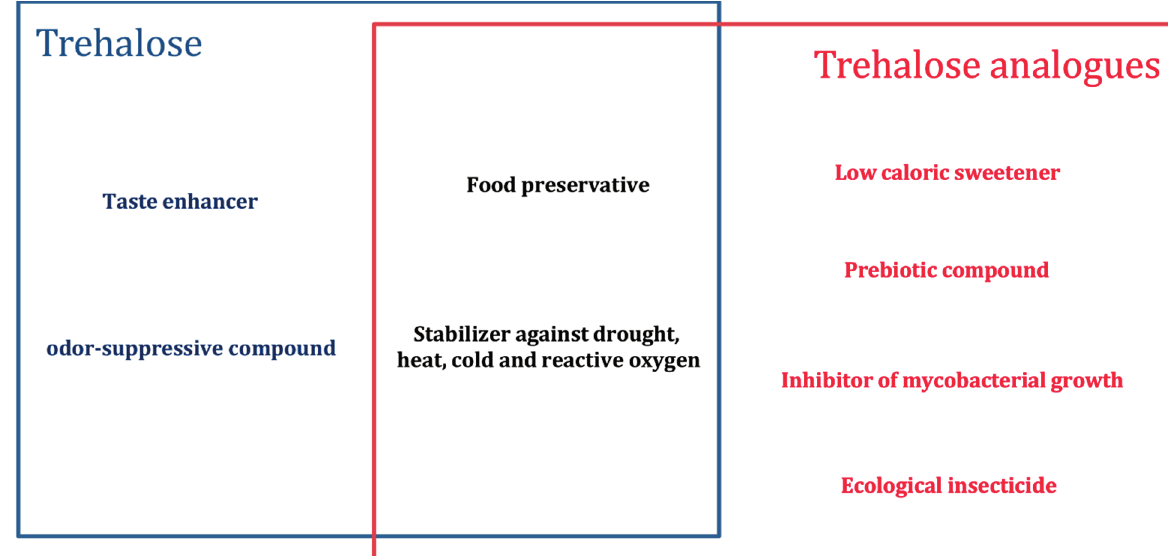
Figure 2. Summary of applications for trehalose and its analogues in food, pharmaceutical, cosmetics and agricultural